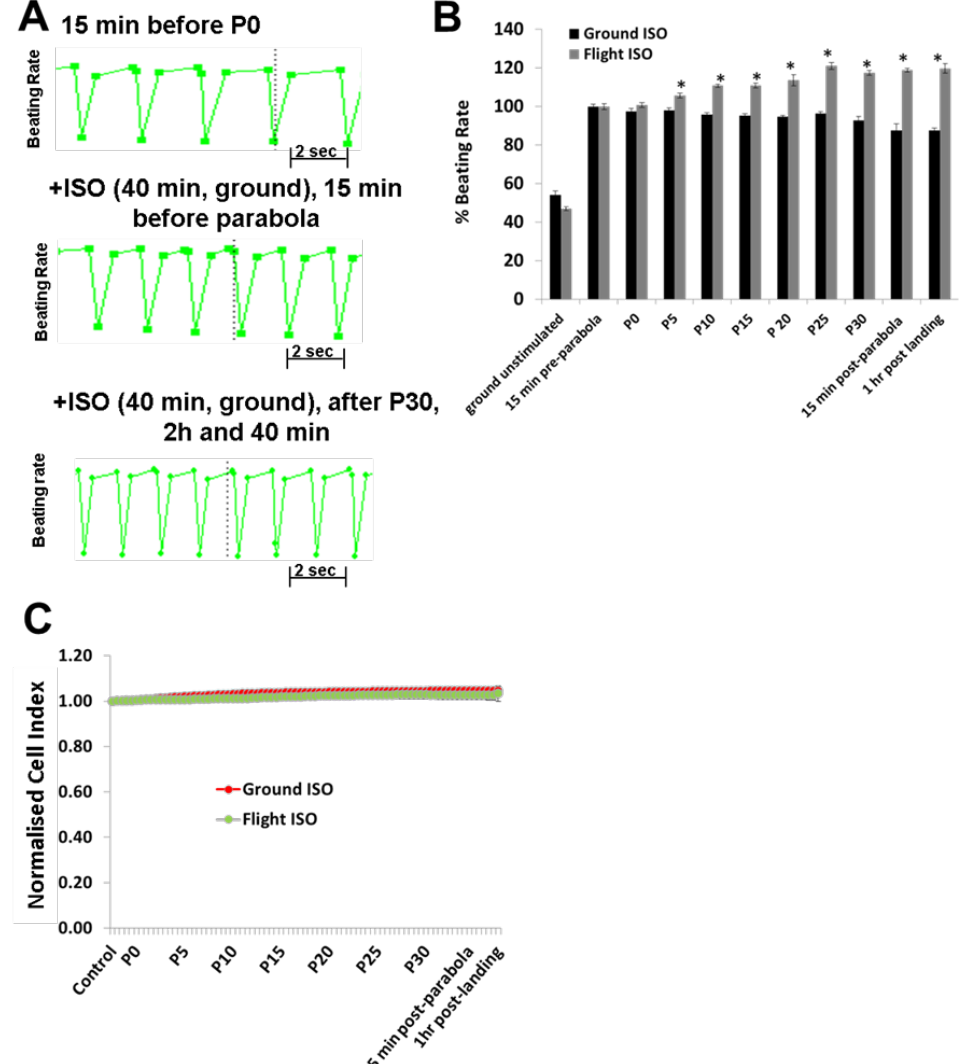
Figure 3. Analysis of the beating rate (BR) of human cardiomyocytes (hCMs) stimulated with isoprenalin (ISO; 1 µ M) during the parabolic flight experiments ( A ) Upper panel: Representative BR pattern of unstimulated hCMs recorded 15 min (1 g ) prior to the first parabola (P0); Middle panel: Representative BR pattern of hCMs when stimulated with agonists 40 min prior to the parabolic flight and monitored 15 min before starting parabola P0. Lower panel: Representative BR pattern of hCMs measured after 31 parabolas. ( B ) Data from three independent parabolic flight experiments, each executed in triplicate, as well as data collected from the 1 g ground experiment carried out in parallel. The results were normalized by setting the ISO-induced BR of the ground control experiment prior to P0 to 100% (mean ± SEM, n = 9, * p < 0.05 for the ISO control versus the ISO parabolic flight values). ( C ) Parallel monitoring of the cell viability expressed as the cell index (CI) value. The CI values were normalized by setting the control values to 1. SEM, standard error of the mean.